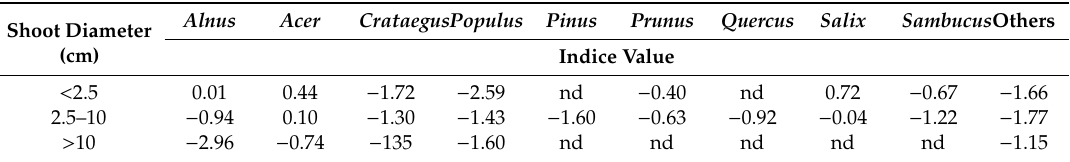
Figure 2. Woody plant diameters available (in dark gray) and browsed by beavers ( in light gray) with the electivity values (Ivlev’s electivity indice with Jacob’s modification) in all the transects located along the Gwda River. Table 4. Electivity values of browsed plants inventoried in transects located along the Gwda River, in three diameter classes for nine woody plant genera.